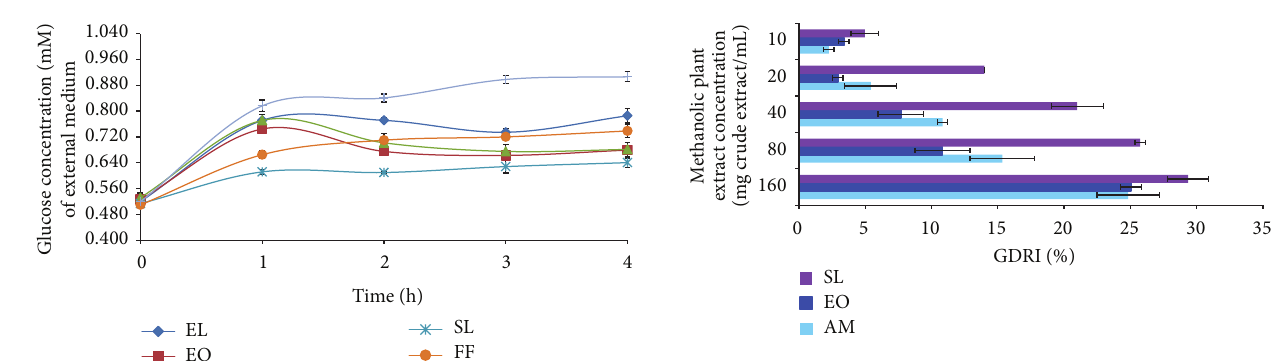
Figure 3: Dose-dependent effect of SL, EO, and AM extracts on glucose diffusion.